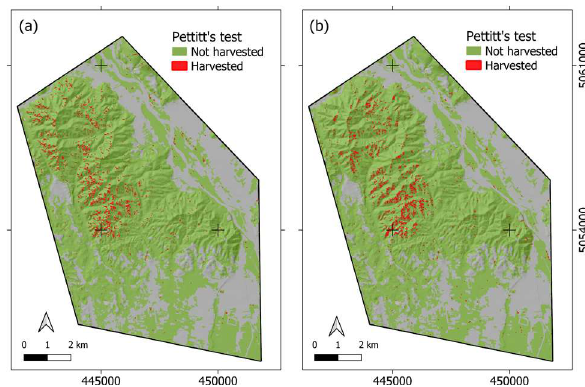
Figure 5 . Forest harvestings classification by Pettitt’s test method for (a) ascending CRTS and (b) for descending CRTS. Reference frame is WGS84 UTM 32N.